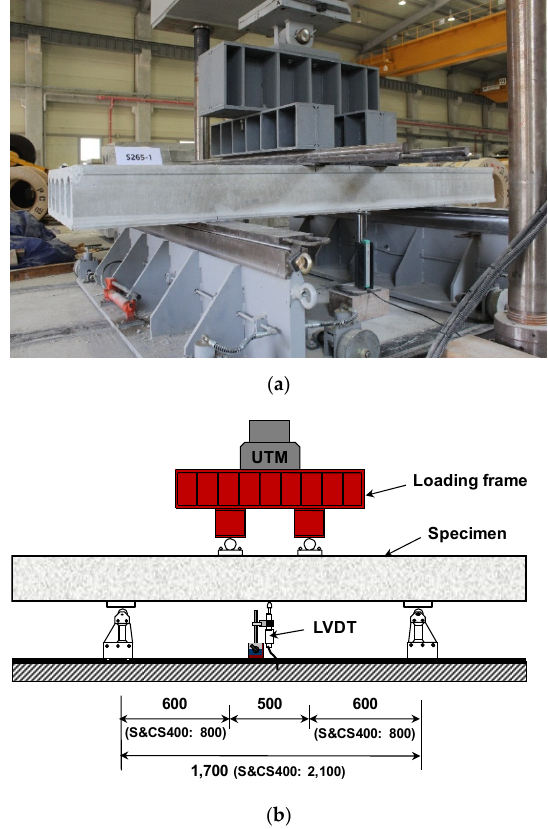
Figure 6. Test setup (unit: mm): ( a ) Photograph; ( b ) Elevation view.